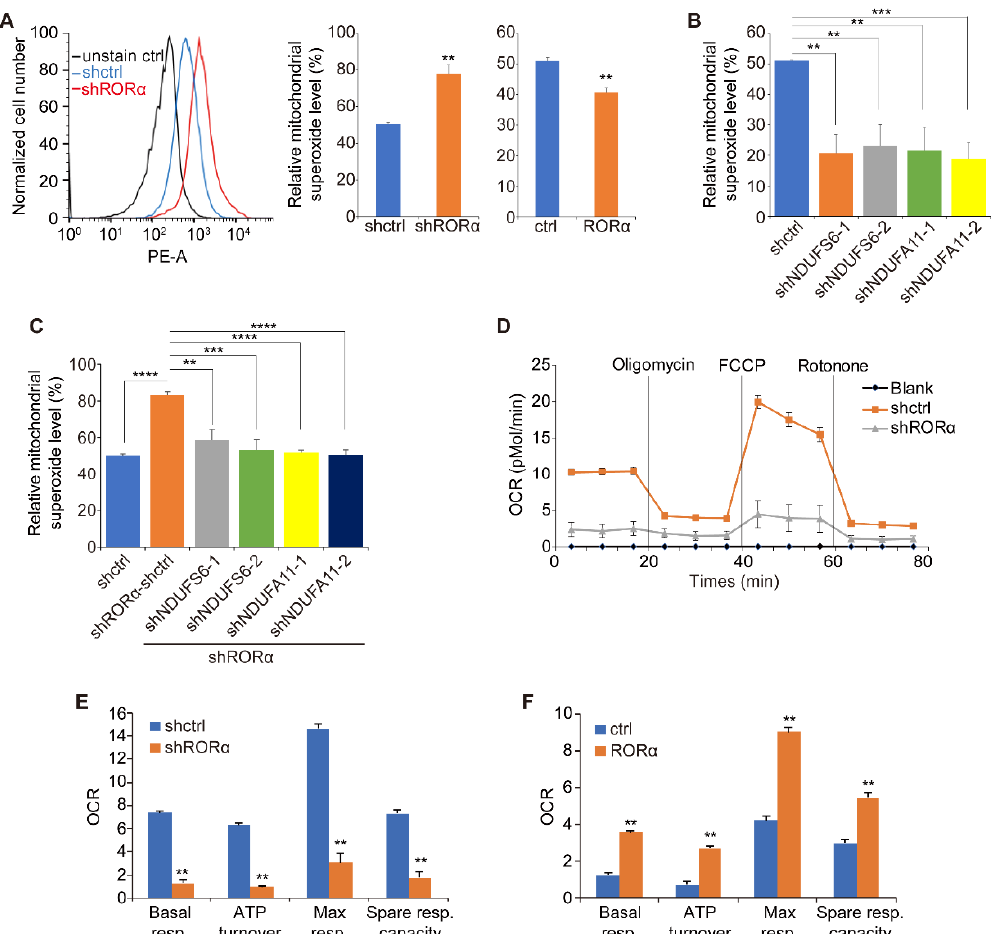
Figure 3. ROR α inhibits ROS production by repressing the expression of complex I genes. ( A ) FACS quantification of mitochondrial superoxide levels in control and ROR α -silenced MCF-10A cells, and in control and ROR α -expressing MDA-MB-231 cells; results are presented as mean ± SEM; n = 4, ** p < 0.01, student’s t -tests. ( B ) FACS quantification of mitochondrial superoxide levels in control or NDUFS6-silenced or NDUFA11-silenced MDA-MB-231 cells; results are presented as mean ± SEM; n = 4, *** p < 0.001, ** p < 0.01, one-way ANOVA test. ( C ) FACS quantification of mitochondrial superoxide levels in control or ROR α -silenced or ROR α &NDUFS6-silenced or ROR α &NDUFA11-silenced MCF-10A cells; results are presented as mean ± SEM; n = 6, **** p < 0.0001, *** p < 0.001, ** p < 0.01, one-way ANOVA test. ( D ) Seahorse analysis quantified OCR in control and ROR α -silenced S1 cells. ( E ) Seahorse analysis quantified OCR in control and ROR α - silenced S1 cells; results are presented as mean ± SEM; n = 12, ** p < 0.01, student’s t -tests. ( F ) Seahorse analysis quantified OCR in control and ROR α -expressing MDA-MB-157 cells; results are presented as mean ± SEM; n = 12, ** p < 0.01, student’s t